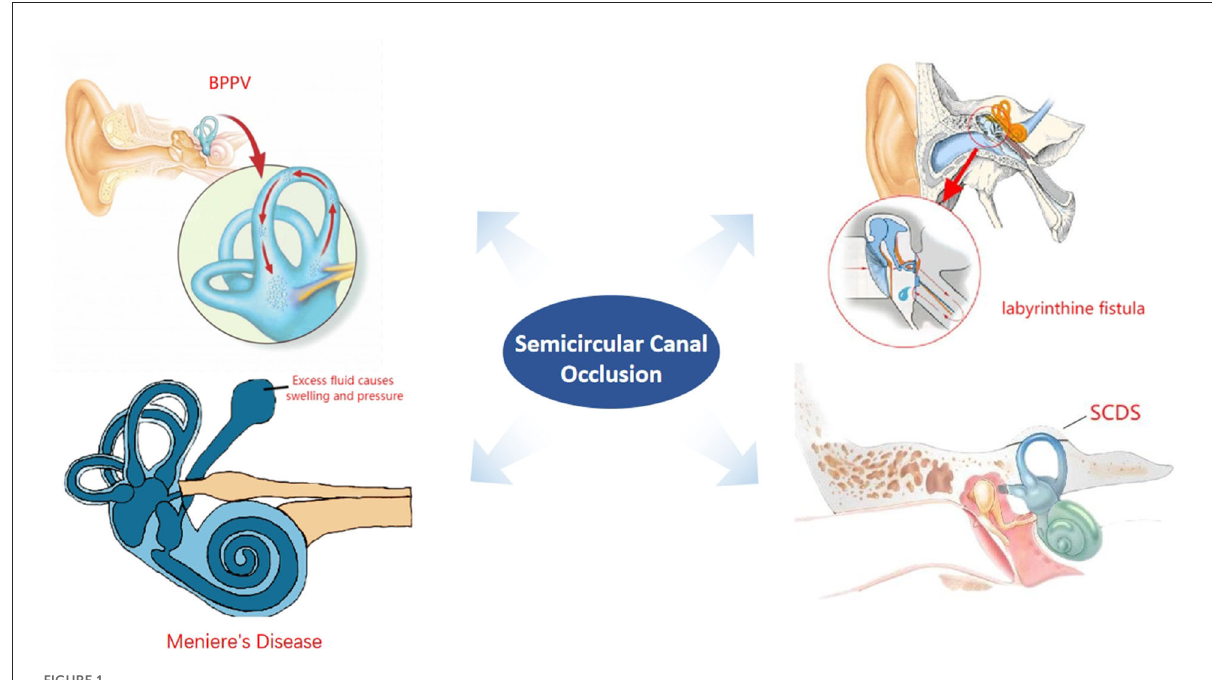
FIGURE1 Development of semicircular canal